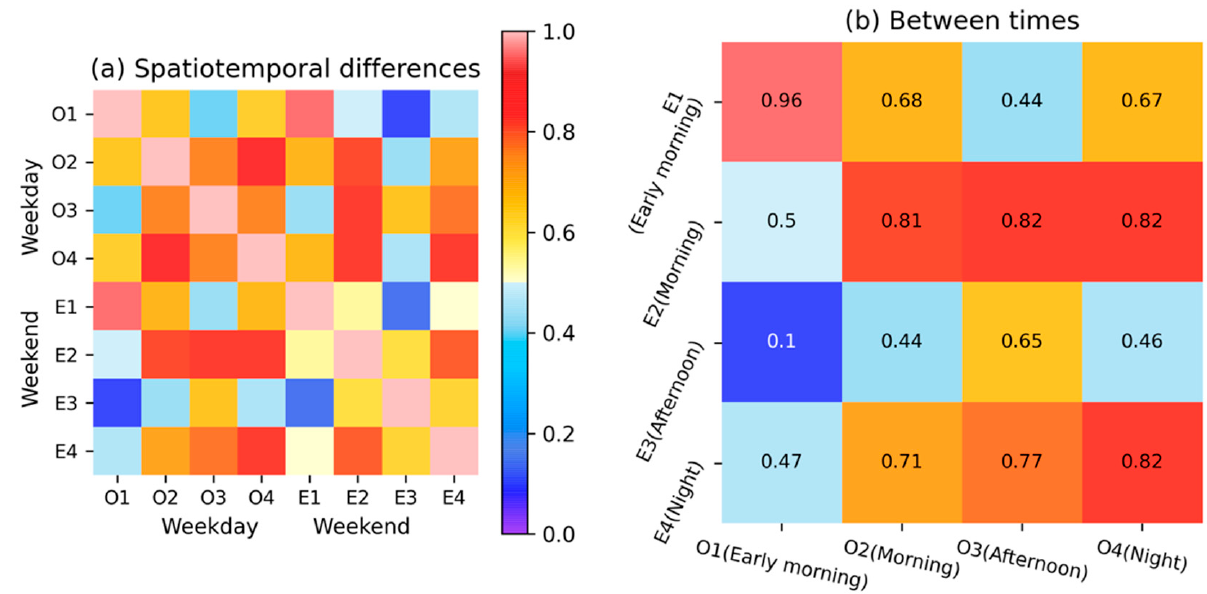
Figure 7. Heatmap for the spatiotemporal similarity of leisure activities. The closer the value is to 1, the higher the similarity. Axis labels starting with “O” indicate weekdays, and those starting with “W” indicate weekends.